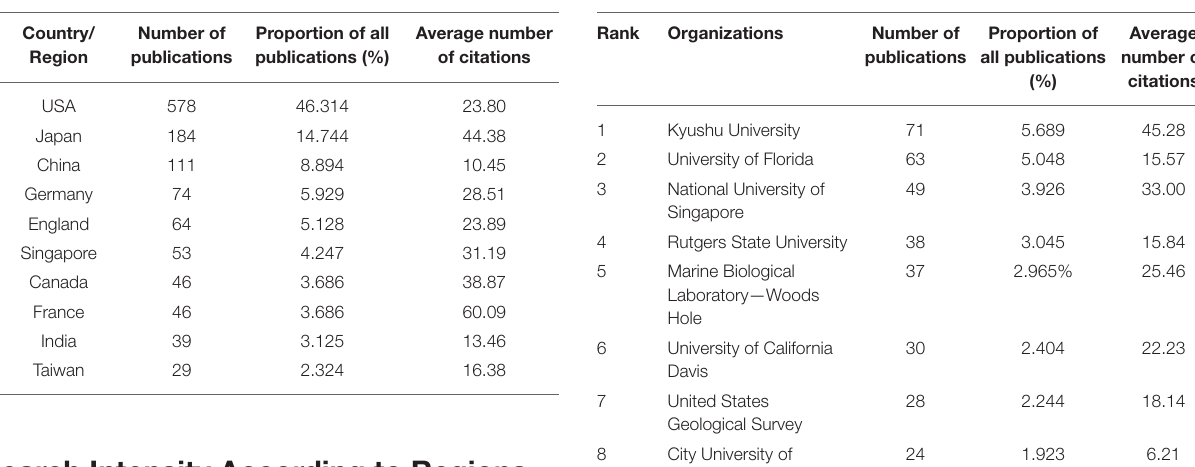
TABLE 3 | Numbers of publications, the proportion of all publications, and the total number of times the top 10 source journals are cited and ranked by the number of publications based on